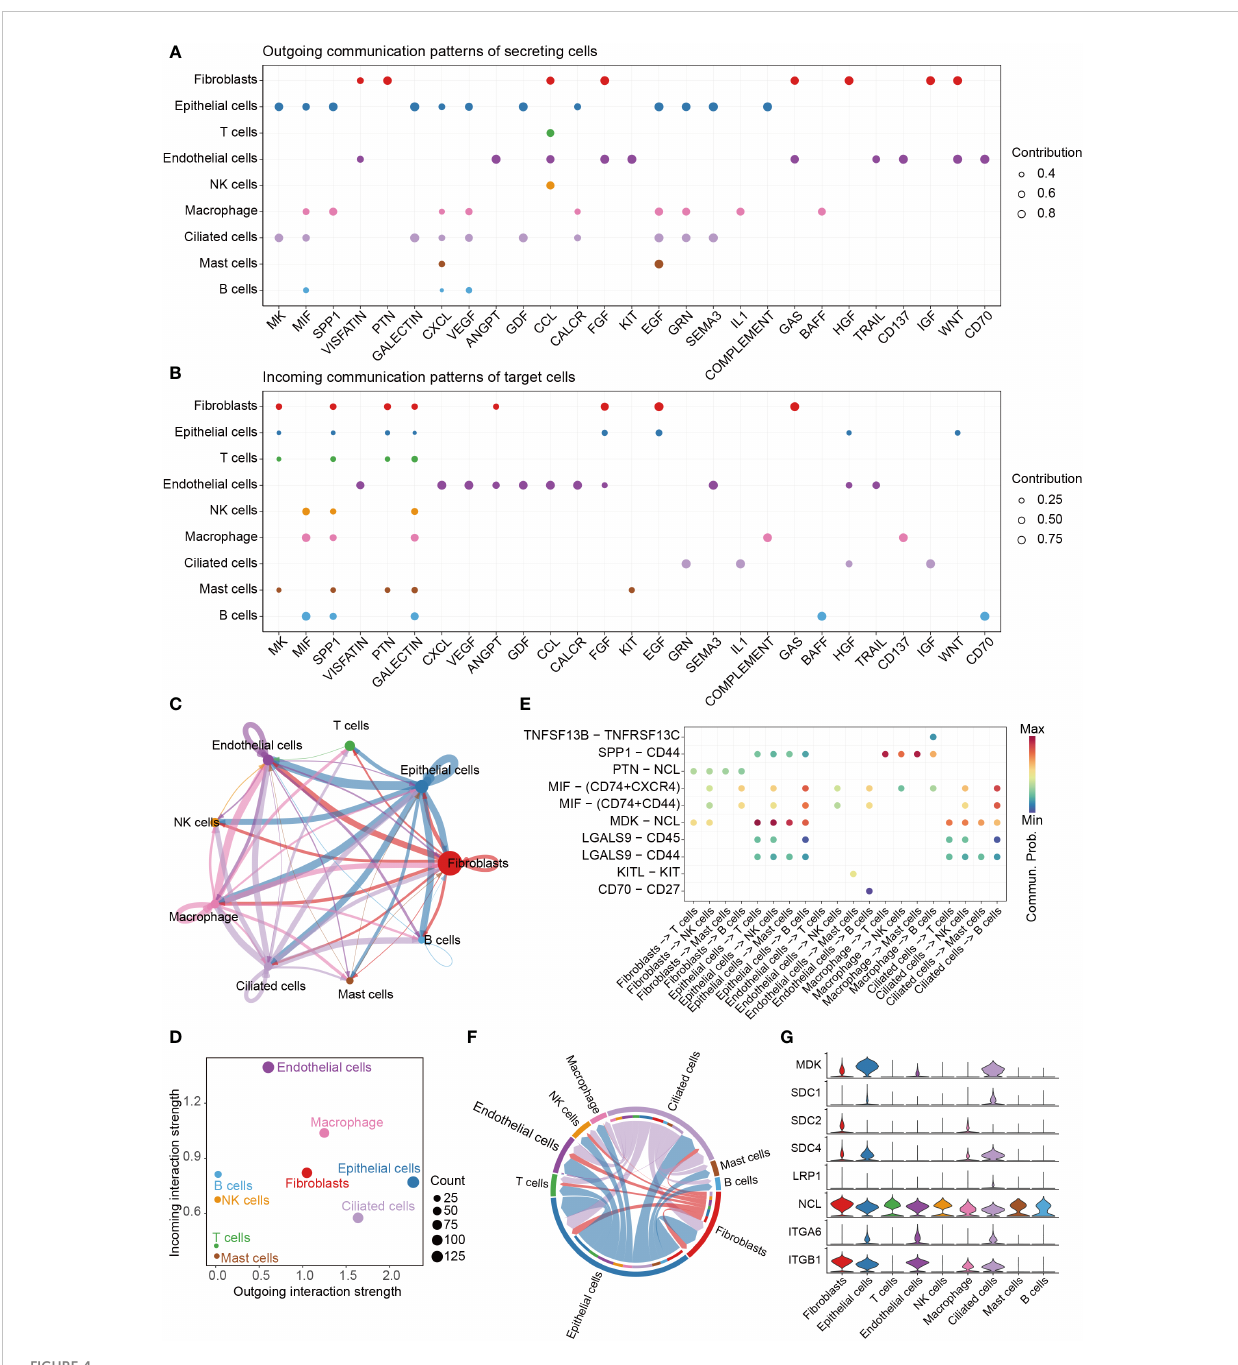
FIGURE 4 Cell-cell communication. (A) The dot plot showing the comparison of outgoing signaling patterns of secreting cells. (B) The dot plot showing the comparison of incoming signaling patterns. (C) Circle plot showing the communication strength between interacting cells. (D) Outgoing and incoming interaction strength of the cells. (E) Comparison of the signi fi cant ligand-receptor pairs between cells, which contribute to the signaling from fi broblasts, epithelial cells, endothelial cells, macrophage and ciliated cells to T cells, NK cells, Mast cells and B cells. (F) Chord plot showing inferred intercellular communication network of MK signaling. (G) Violin plots showing the expression of the 8 genes involved in MK signaling